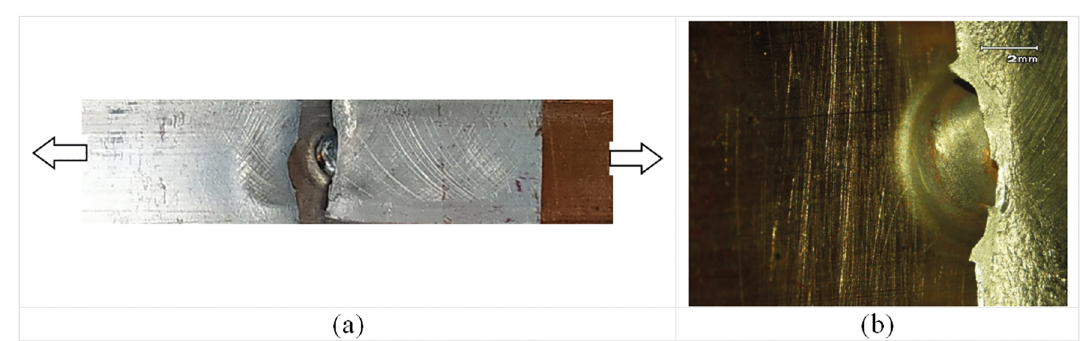
Figure 12. Fracture mechanisms: (a) overview of joint failure and (b) detail of aluminium sheet.